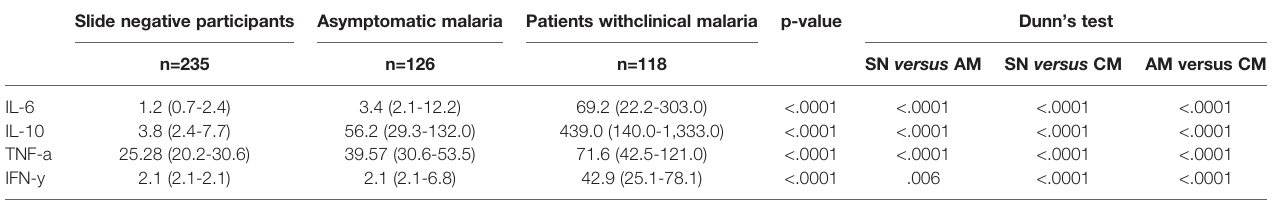
TABLE 2 | Circulating cytokine concentrations among malaria slide negative participants, participants with asymptomatic malaria and patient with clinical malaria. Slide negative participants Asymptomatic malaria Patients withclinical malaria